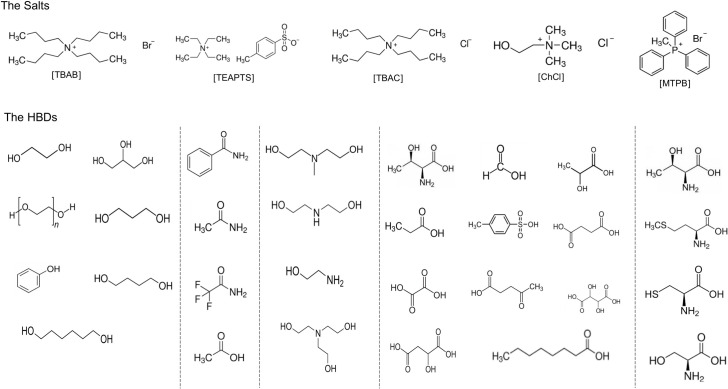
Structures of the salts and HBDs of DESs.(A) alcohols-based HBD, (B) amide-based HBD, (C) amine-based HBD, (D) organic acid-based HBD, (E) organic amino acid HBD. (n = 2 (DEG), 3 (TEG), 4 (PEG-4) and 8 (PEG-8)).